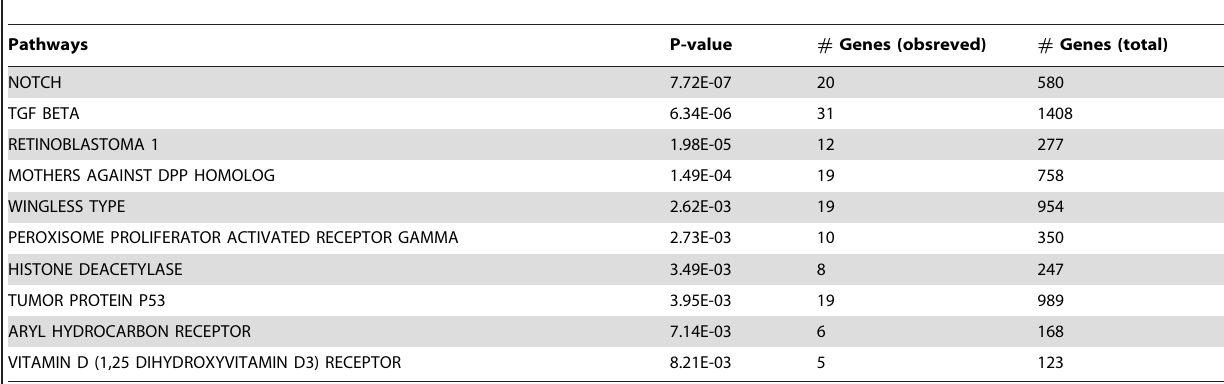
Table 2. Pathways in which 148 H342-downregulated genes of transcription regulation involved.